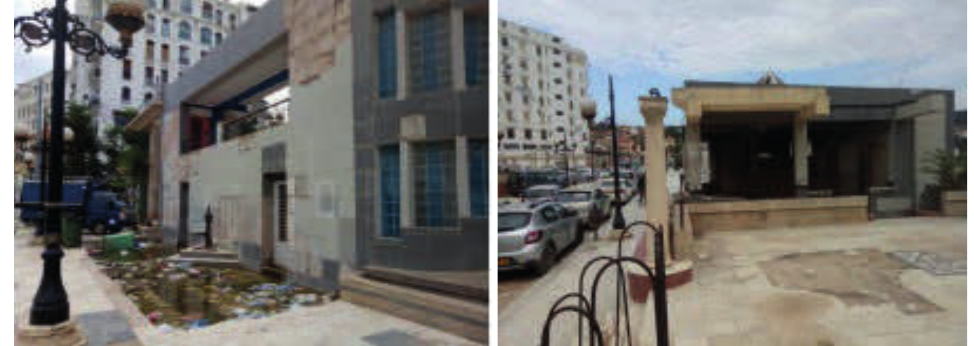
Fig. 10. Dilapidated state of the Kerkeri place (created by the